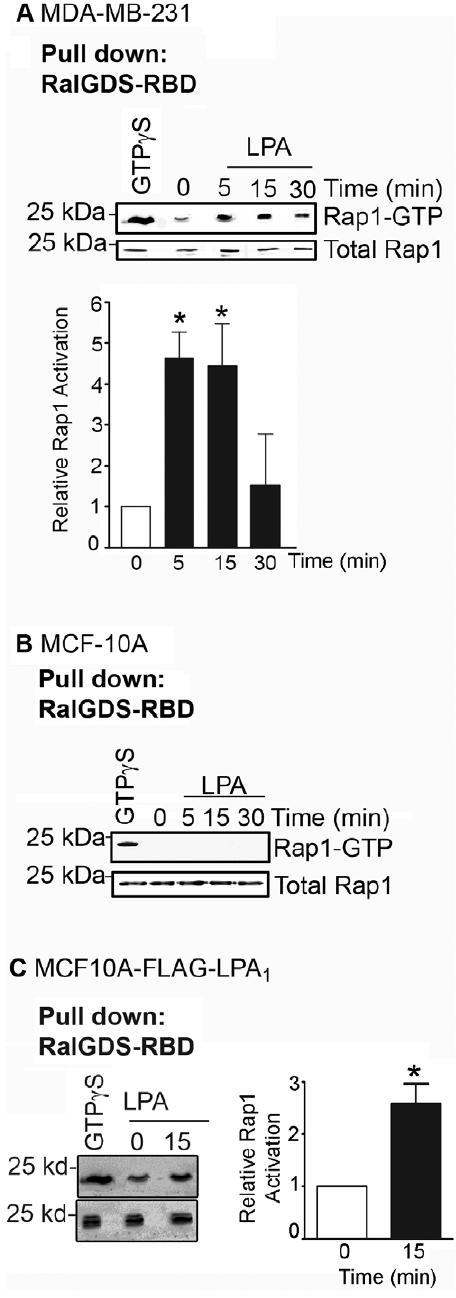
Figure 4. LPA stimulates Rap1 activity in breast cancer cells but not in non-malignant cells. MDA-MB-231 breast cancer cells were serum-starved for 4 hours and stimulated with 10 m M LPA for the indicated times. Cells were then lysed and activated Rap1 was pulled down using RalGDS-RBD-conjugated beads and immunoblotted using a rabbit anti-Rap1 antibody. A representative blot from four independent experiments is shown. (B) MCF-10A cells were stimulated with 10 m M LPA for the indicated times and Rap1 activation was determined. Blot is representative of three independent experiments. (C) MCF-10A cells stably expressing FLAG-LPA 1 were treated for 15 minutes with 10 m M LPA and subjected to Rap1 activation assay. Blot is representative of three independent